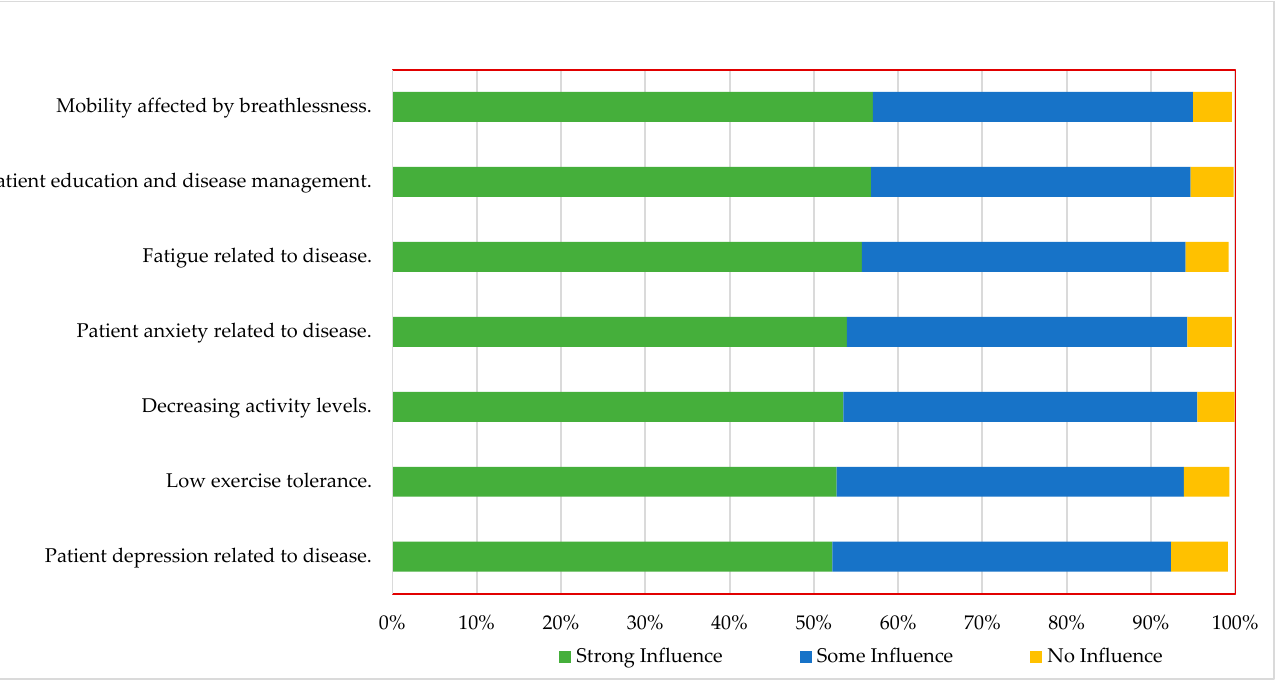
Figure 1. Patient-related factors that influence referral decisions for cardiopulmonary rehabilitation, using strong, some, or no influence as grading tools ( n = 1056).